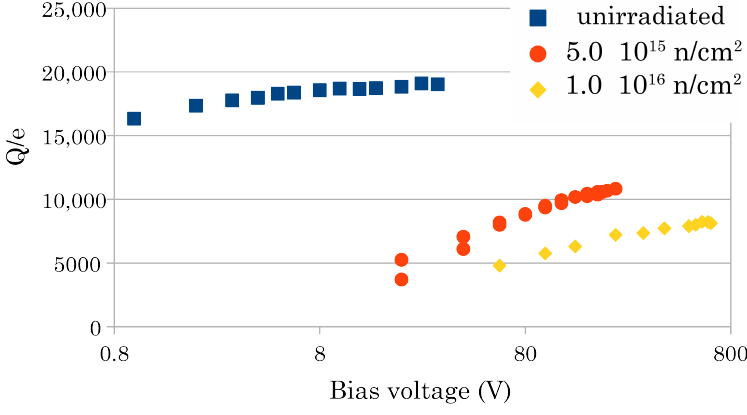
Figure 5. S-curves of the 500 col/mm 2 sensor in semi-log scale.